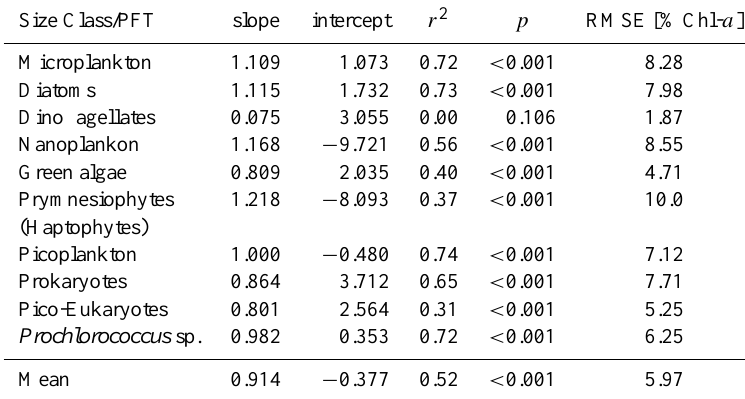
Table 4. Statistical results of the